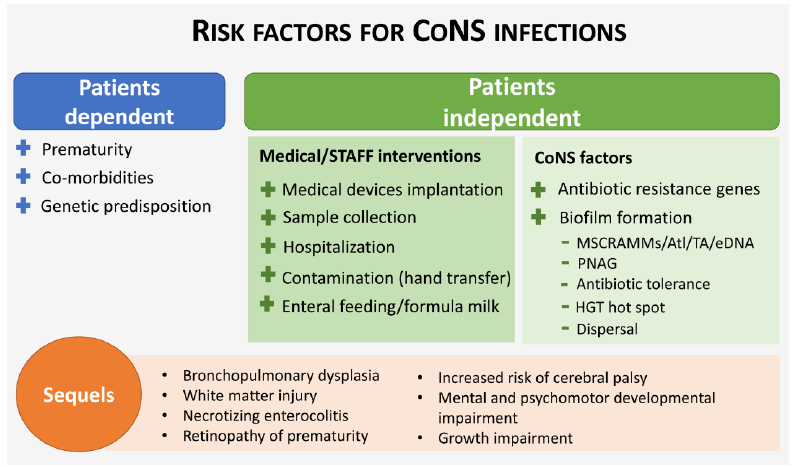
Figure 1. Summary of the several aspects contributing to the development of CoNS-caused infections in preterm infants. MSCRAMMS, microbial surface components recognizing matrix molecules; Atl, autolysins; TA, teichoic acids; eDNA, extracellular DNA; PNAG, poly-N-acetylglucosamine; HTG, horizontal gene transfer. While the use of indwelling medical devices generates an increased risk for CoNS- related LOS, one-third of LOS cases are not associated with medical devices [97], suggest- ing other risk factors/sources of infection. For instance, the use of formula feeding [95,98,99] and parenteral nutrition with glucose can increase the risk of preterm infants being infected with CoNS [100]. Gut colonization is another route of contamination in preterm infants with immature intestinal mucosal barriers and dysbiosis [101,102]. The gut of preterm neonates becomes colonized, within the first days, with S. epidermidis and S. haemolyticus carrying the mecA gene, which is associated with an increased risk of infec- tion [103]. These strains spread in the NICU afterwards causing LOS [102,104,105]. Indeed, it was shown that S. epidermidis can translocate from the gastrointestinal tract into the bloodstream causing infection [101,102]. Furthermore, it was found that S. capitis also col- onizes the gut of neonates. Butin et al. observed that among the neonates evaluated, 36% had at least one stool culture positive for S. capitis during hospitalization [106]. However, differently than S. epidermidis or S. haemolyticus , the presence of S. capitis in the gut micro- biota was not a risk factor for LOS development. This suggests that the gut may serve as a reservoir of S. capitis but this is not enough to induce LOS [106]. The presence of such strains/species in the gut before the emergence of LOS [102,104,105,107] indicates that al- terations in the gut microbiota could prevent the development of LOS [86]. As detailed in Section 2, this could be achieved by feeding neonates with maternal milk that is rich in CoNS that are mecA negative [80,85]. Finally, the colonisation rate among gynecological surgical staff with methicillin - re- sistant CoNS constitutes another important route of contamination of preterm babies. In- deed, it has been shown that the hands of healthcare personnel are the major sources of S. epidermidis transmission among neonates [97,102,108]. Thus, hygiene policies need to be revisited and strictly followed to decrease this venue of contamination. 3.2. CoNS Virulence Factors The virulence potential of bacteria is normally defined by their capacity to produce toxins. In the case of CoNS species, although they produce and secrete toxins and exoen- zymes, they normally rely on immune evasion mechanisms to cause infection [109]. One of the major factors contributing to CoNS pathogenesis is their ability to form biofilms